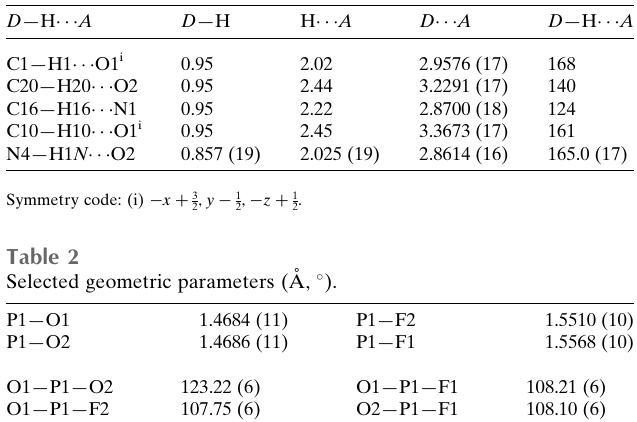
Table 1 Hydrogen-bond geometry (A˚ , (cid:4) ).